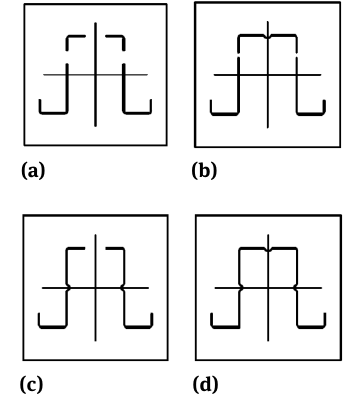
Figure 8: View of effective cross-section area of analysed hat pro- files – bending by the main axis y-y: a) profile without longitudinal stiffeners, b) profile with stiffener on upper chord, c) profile with stiffeners on webs, d) profile with stiffeners on upper chord